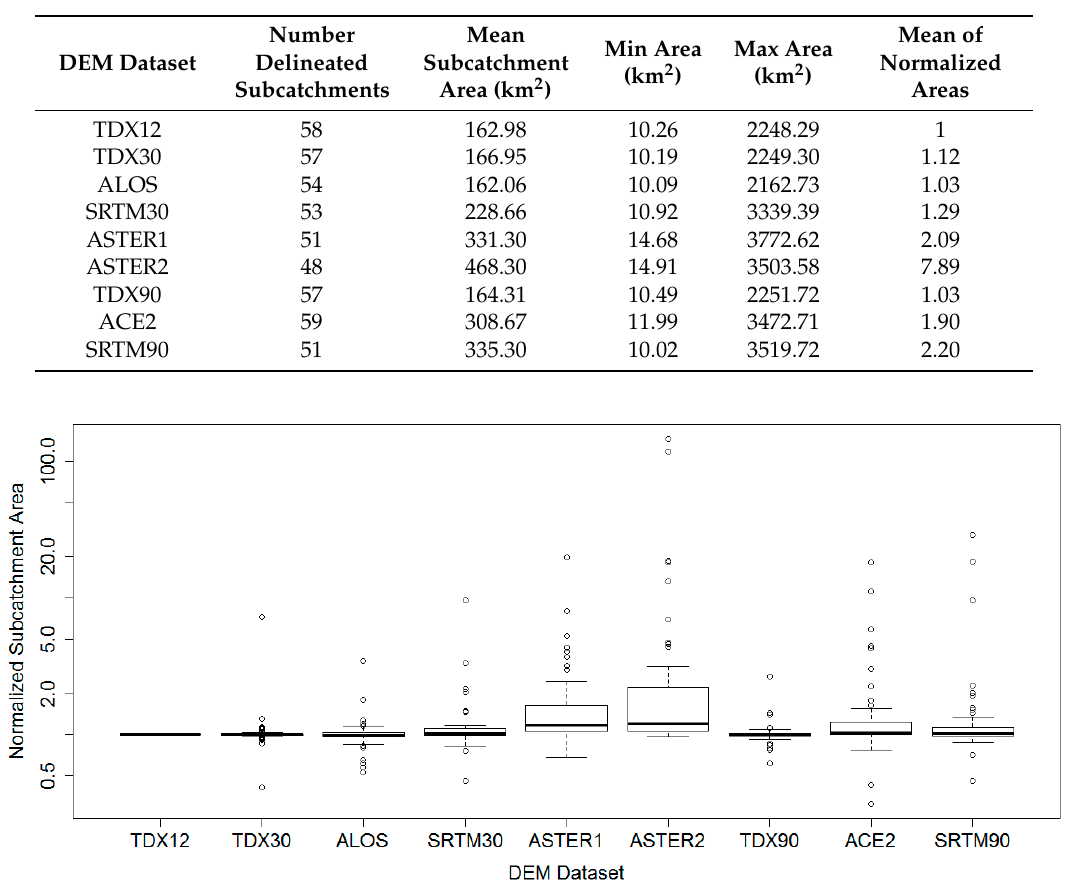
Table 2. Number of subcatchments, mean subcatchment areas, min and max areas, and mean subcatchment areas normalized to the underlying TDX12 subcatchment (area ratios). The TDX12, TDX30, TDX90, and ALOS datasets exhibit similar characteristics, followed by SRTM30, then by ASTER1, ACE2, and SRTM90. ASTER2 is an outlier, with fewer subcatchments that averaged much larger than their corresponding TDX12 subcatchments.